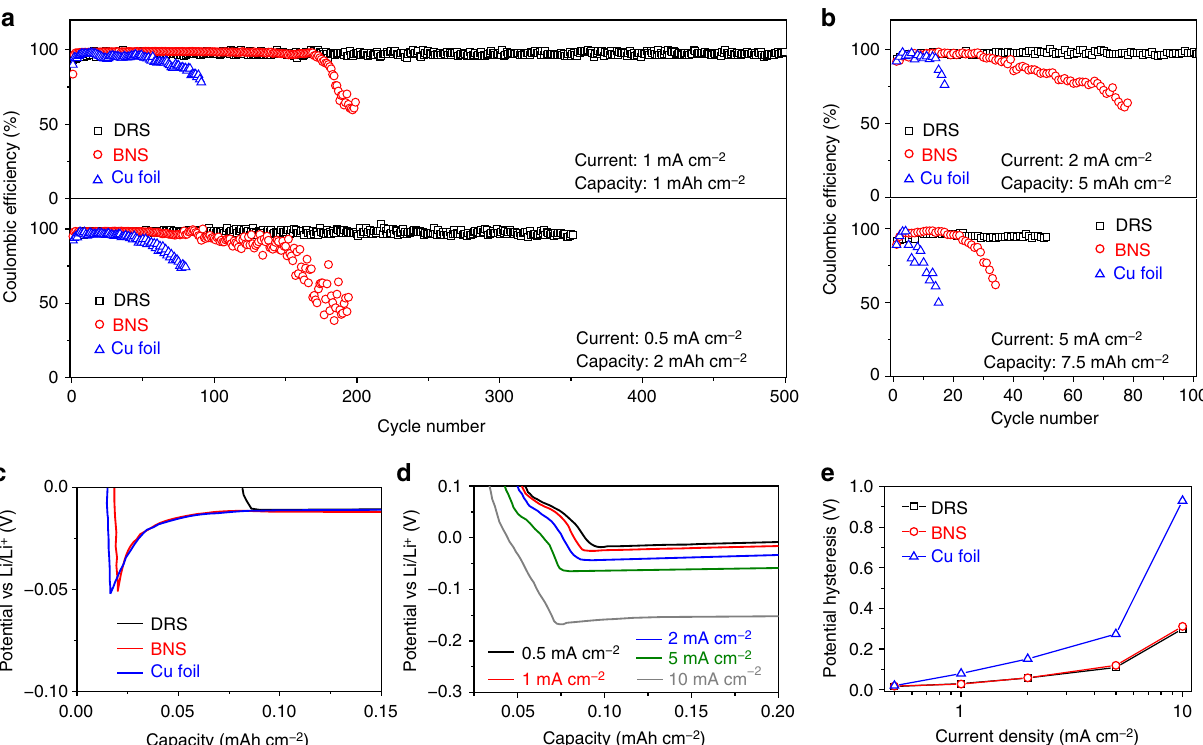
Fig. 3 Electrochemical properties of DRS, BNS, and Cu-foil current collectors. a , b CEs of Li plating/stripping at different current densities and capacities. c Nucleation overpotentials for Li plating in the three electrodes at ~0.15 mAcm − 2 . d Voltage pro fi les of Li plating/stripping on a DRS at different current densities. e Voltage gap between charge/discharge pro fi les at different current